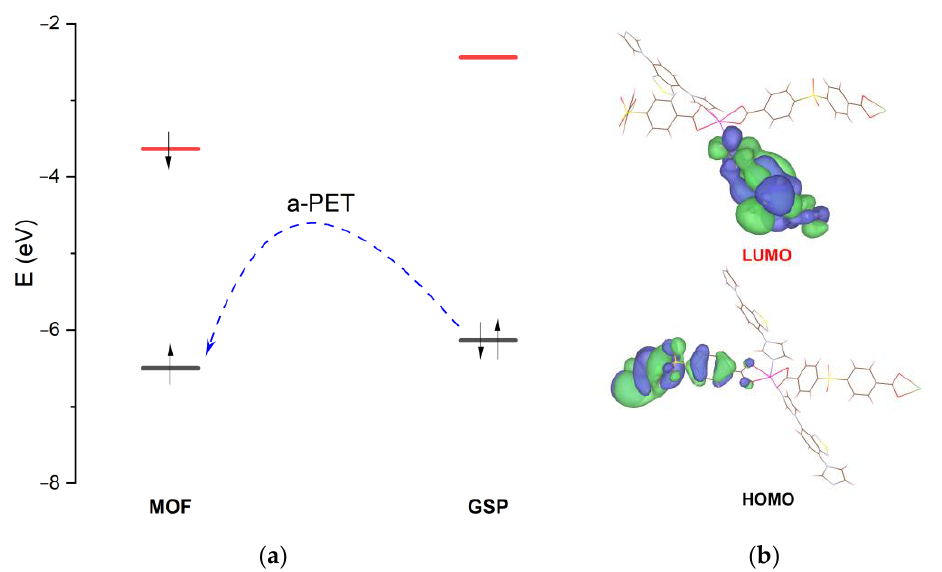
Figure 8. Frontier molecular orbitals of gossypol and MOF model from DFT calculations (B3LYP 6-311+G(2d,p)): ( a ) Energy diagram showing HOMO (black) and LUMO (red) energy levels; ( b ) HOMO and LUMO isosurfaces (at 0.005 e/Bohr 3 ) for the MOF 1 model fragment.